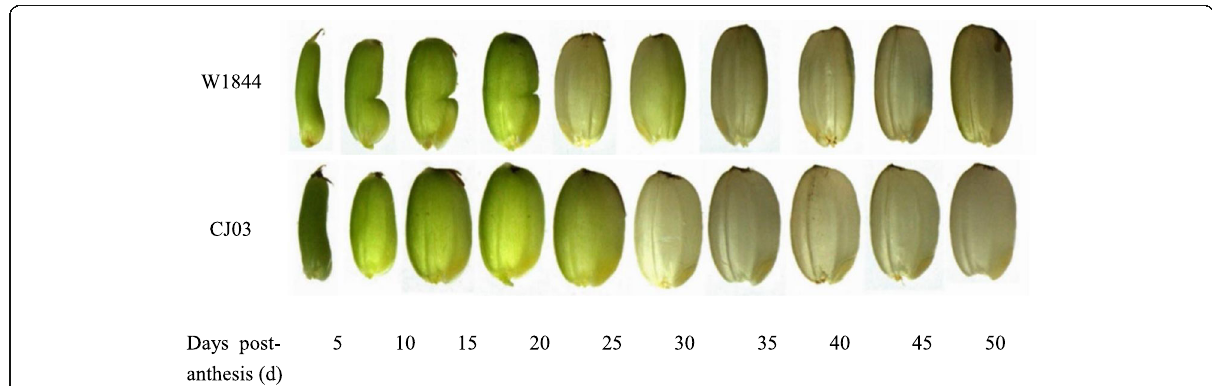
Fig. 2 Dynamic development graph of superior spikelets in the test materials during the grain filling